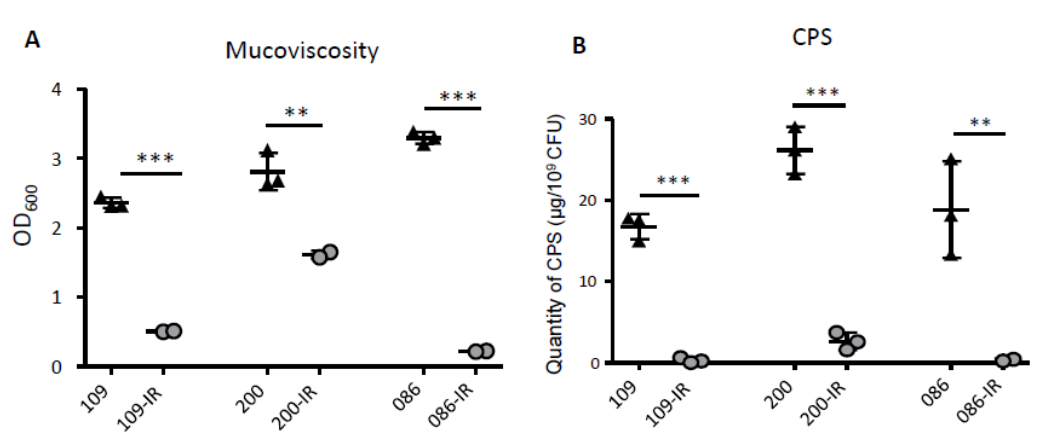
Figure 2. Results of mucoviscosity assay and capsular polysaccharide (CPS) production. ( A ) Mucoviscosity of TGC-S and TGC-IR isolates was measured. The absorbance of supernatants was compared after low-speed centrifugation. ( B ) Production of CPS was quantified in the TGC-S isolates and TGC-IR mutants. CPS biosynthesis was determined by phenol-sulfuric acid assays. **, p < 0.001; ***, p <